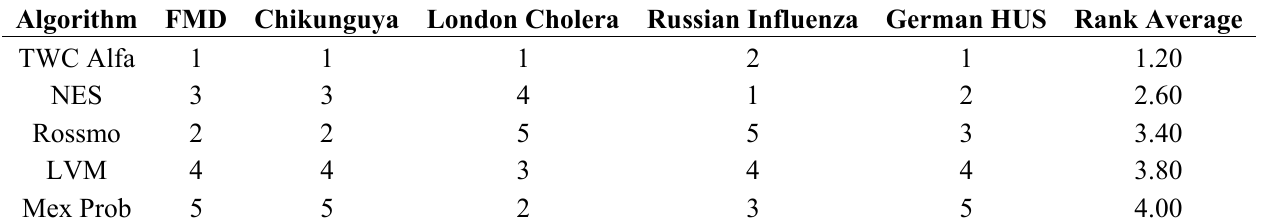
Table 10. The updated average rank of each algorithm in the five tests.